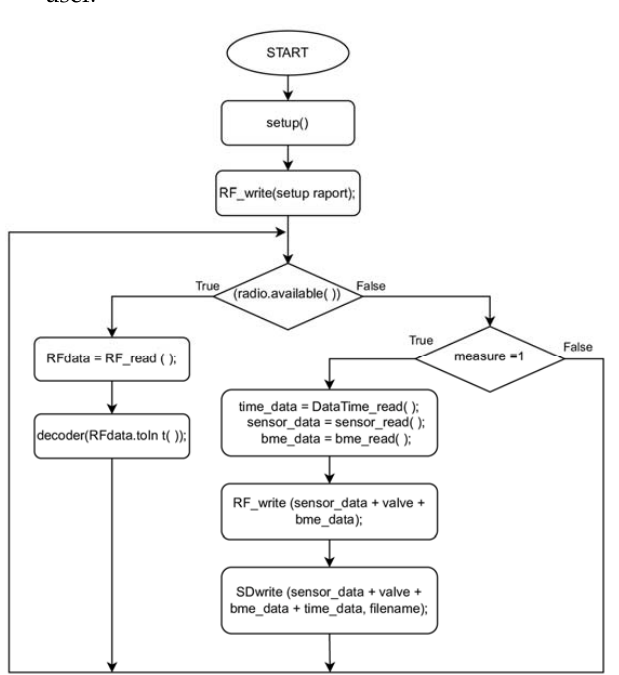
Figure 7. Algorithm of a program managing the operation of the measurement platform.